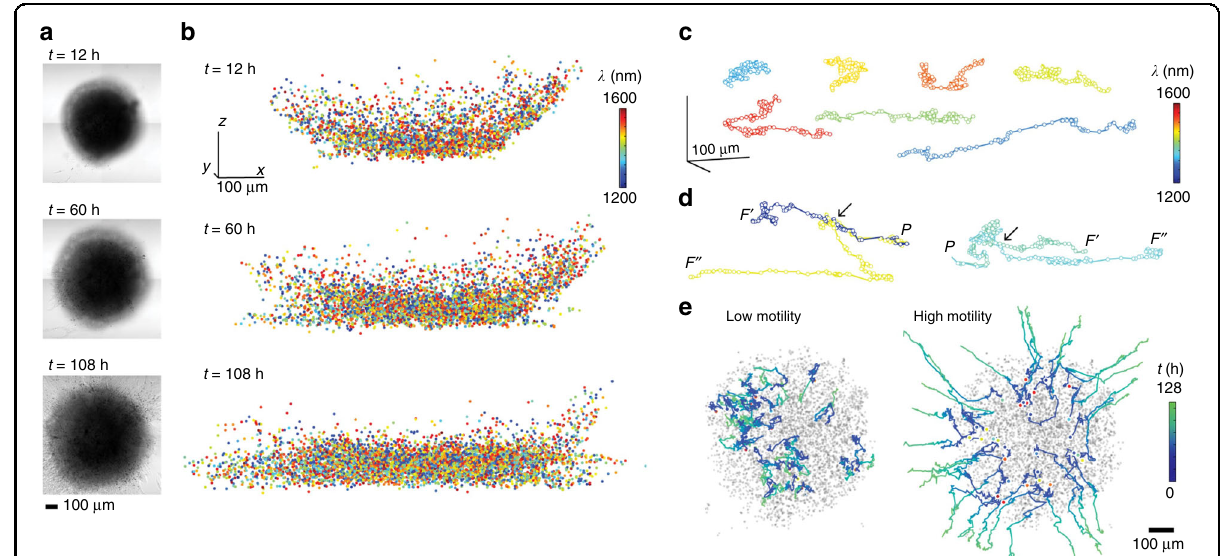
Fig. 4 Illustration of the use of microdisk resonators (so-called laser particles or LPs) for cell tracking in a tumour spheroid upon internalisation. a Optical microscopy images of a tumour taken at different evolution times (12, 60 and 108 h). b Colour-coded tagged image (each colour corresponding to a given wavelength) of the spatial distribution within the tumour. c Mapped trajectories of selected microdisks, with a sampling rate of 1 h. d Trajectories corresponding to single parental cells (P) separating (marked by arrows) into two descendant cells (F ′ and F ′′ ). e Representative paths of cells classi fi ed according to measured average motility: high motility (top 25%) and low motility (bottom 25%). Initial positions are marked with a colour-coded circle depending on the wavelength; the path colour denotes the elapsed time over 128 h. Grey dots denote the positions of all microdisks at 12 h. Reproduced from ref.